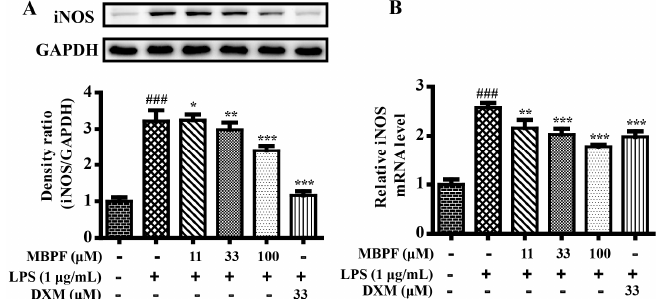
Figure 5. The effects of 4- O -methylbenzoylpaeoniflorin (MBPF) on mRNA and protein level expressions of inducible nitric oxide synthase (iNOS) in LPS-induced RAW 264.7 cells. ( A ) Cells were pretreated with increasing concentrations of MBPF (0, 11, 33, and 100 μ M) for 2 h and were then stimulated with or without LPS (1 μ g/mL) for 24 h. Total proteins of RAW 264.7 cells were prepared for iNOS protein analysis using Western blot; ( B ) cells were pretreated with MBPF (0, 11, 33, and 100 μ M) for 2 h and were then stimulated with or without LPS (1 μ g/mL) for 6 h. The mRNA levels of iNOS were determined using quantitative real-time Polymerase Chain Reaction (PCR) ( C ). Data represent the mean ± SE from three separate experiments. ( ### p < 0.001 vs . control group; * p < 0.05, ** p < 0.01, *** p < 0.001 vs . LPS group).